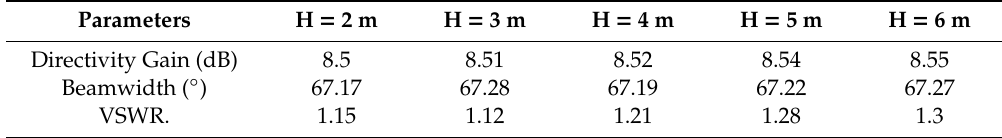
Table 3. The variation of the transmitting antenna characteristics with the erection height.